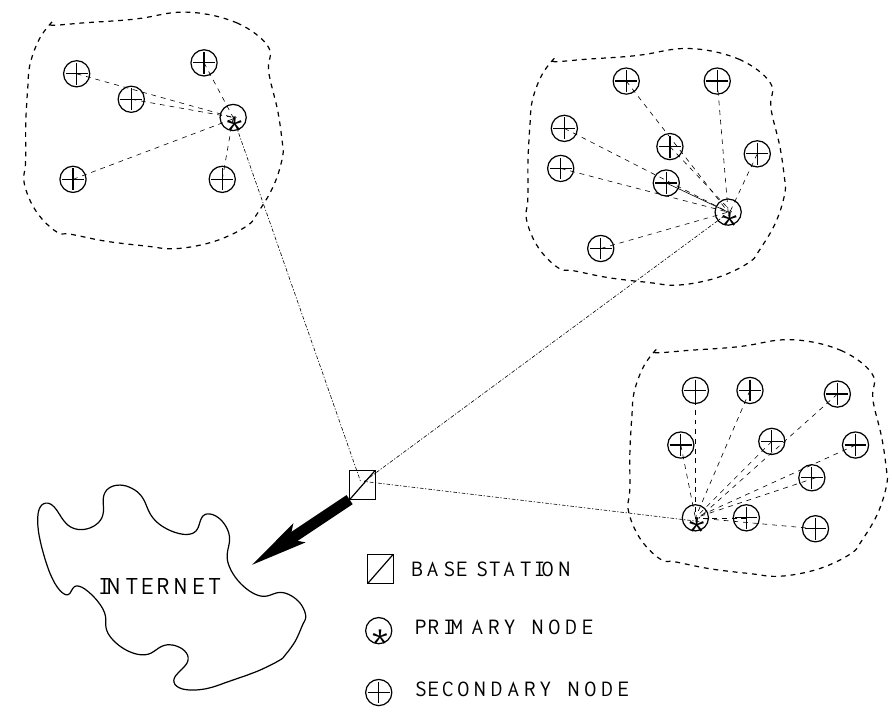
Figure 1. Network